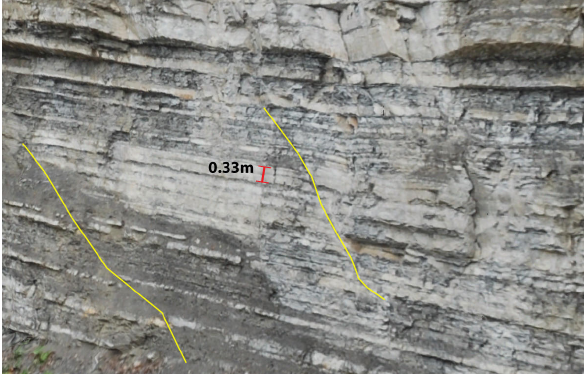
Figure 4. Hyperspectral image of the Jakobsberg Quarry collected with the HySpex SWIR-320me sensor; A: reflectance image as false colour (bands 1442 nm, 2164 nm and 1249 nm shown in RGB); B: MNF image, (bands 5, 6 and 7 shown in RGB).